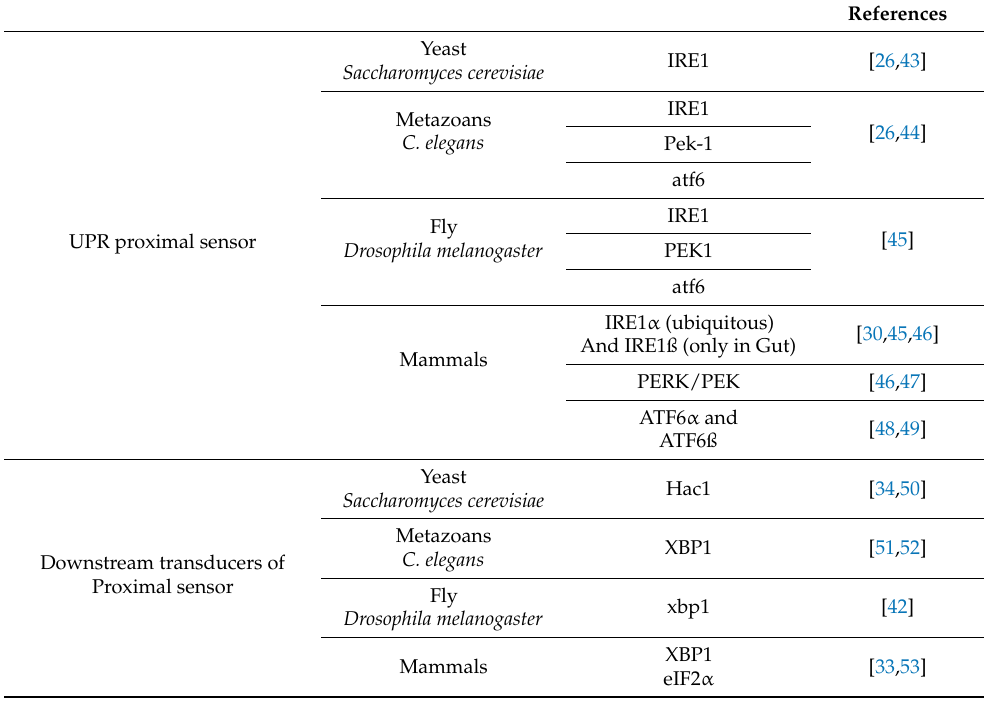
Table 1. Unfolded Protein Response (UPR) sensors from yeast to